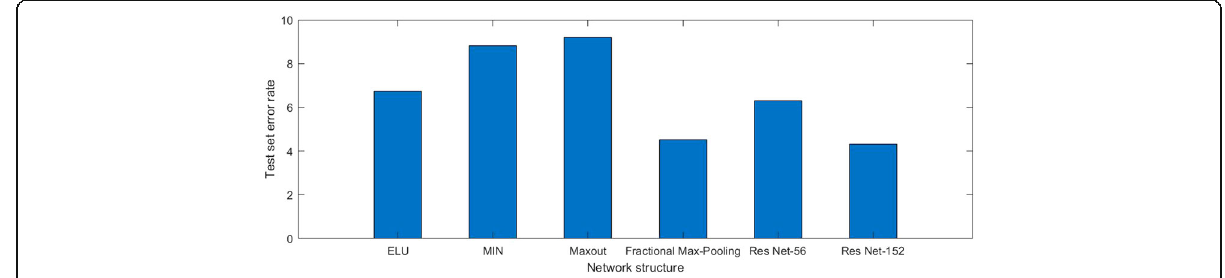
Fig. 9 Error rate of different network